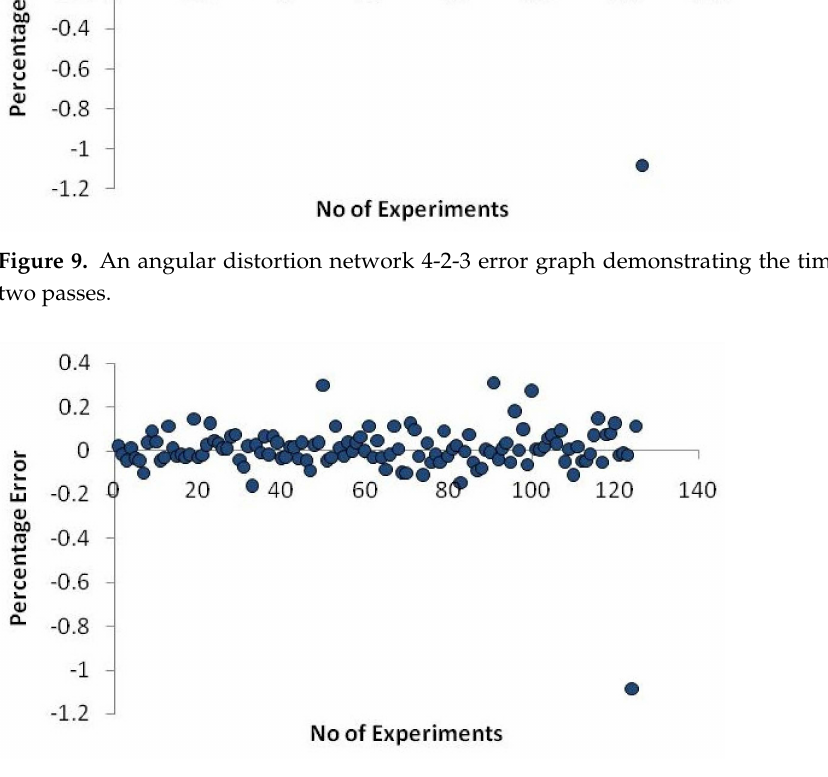
Figure 10. Network 4-2-3 error graph for angular distortion showing time gap between four